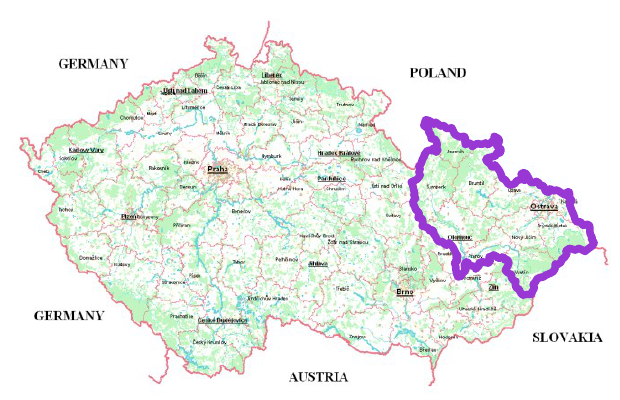
Fig. 1. Locality of